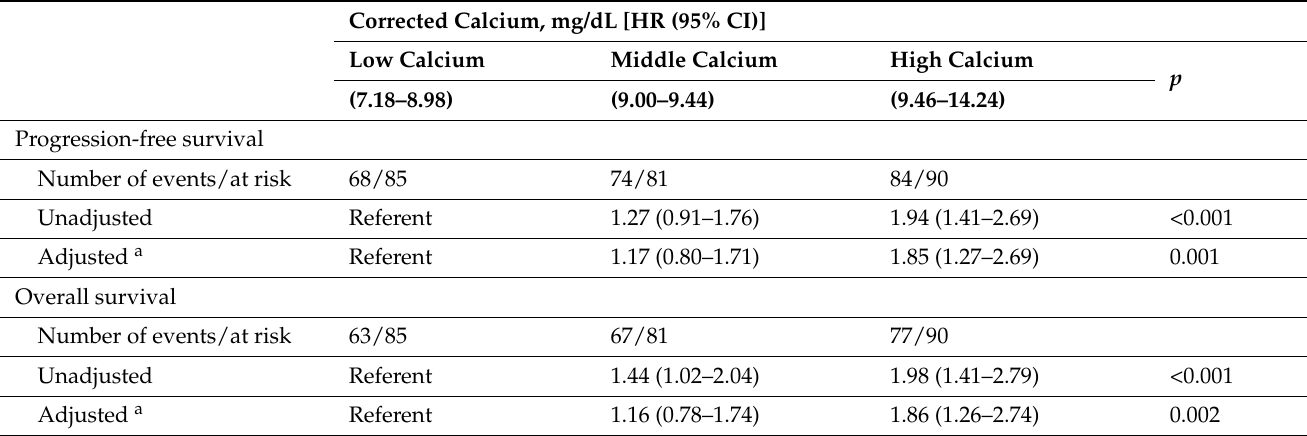
Table 2. Corrected calcium and survival for patients with metastatic colorectal cancer.